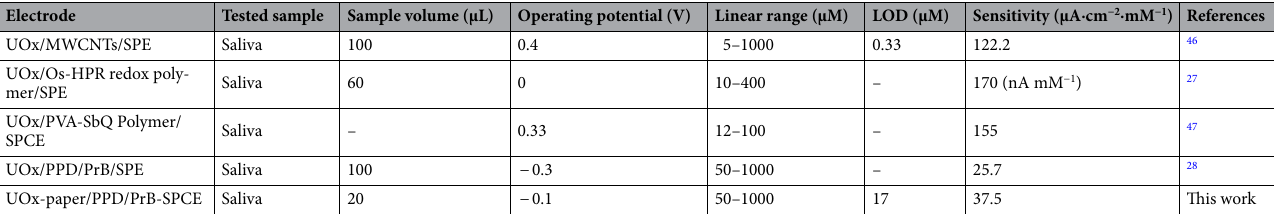
Table 1. Comparison of analytical performance of UOx-paper/PPD/PrB-SPCE with other UOx-treated electrodes. MWCNTs multi-walled carbon nanotubes, Os-HRP osmium-wired horseradish peroxidase, PVA- SbQ pyridinium methosulfate acetal, LOD limit of